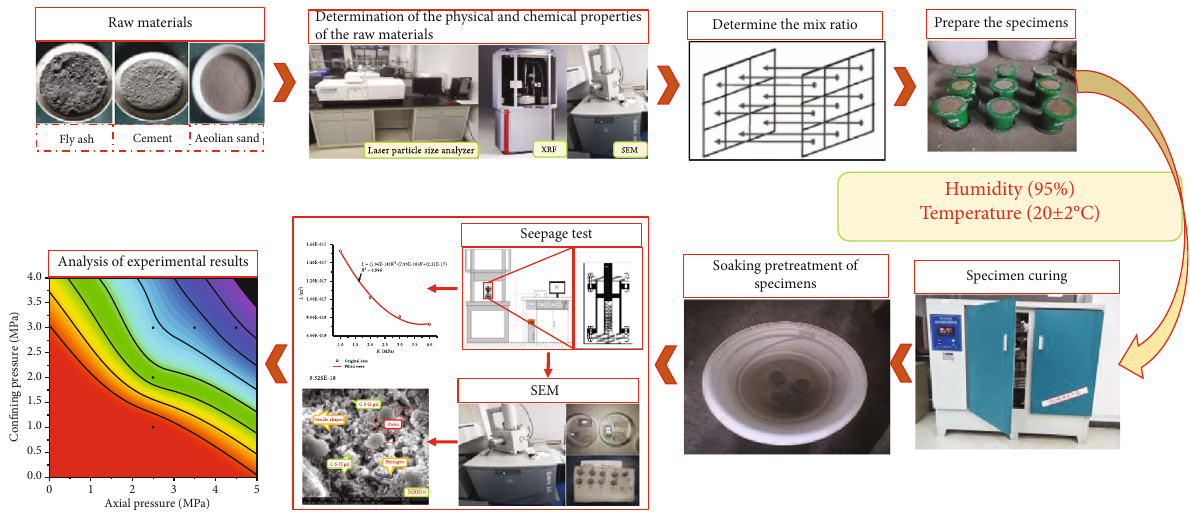
Figure 8: Experimental work fl ow.